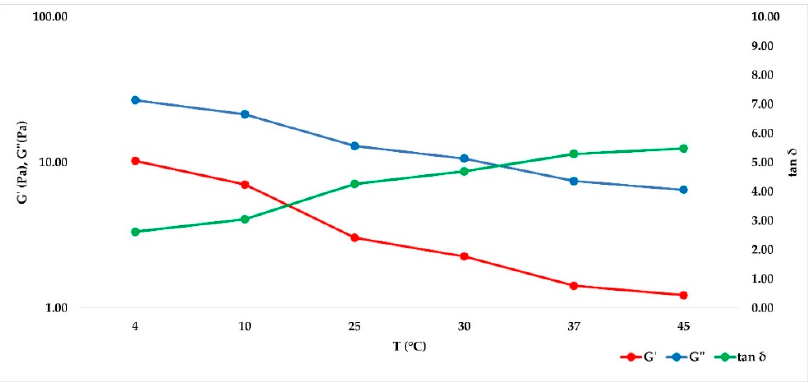
Figure 4. Not cross-linked HA trend of G’, G’’ and tan δ as a function of increasing temperature (4, 10, 25, 30, 37 and 45 °C).